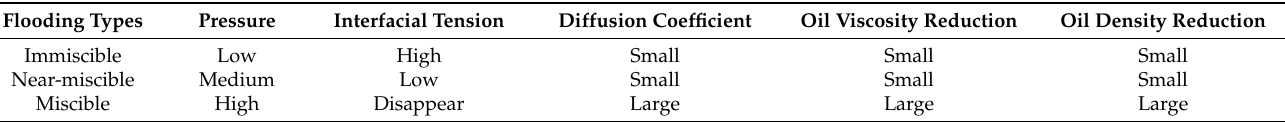
Figure 1. Schematic illustration of pore-scale CO 2 /oil flooding under ( a ) immiscible, ( b ) near-miscible, and ( c ) miscible conditions. Table 1. A comparison between immiscible, near-miscible, and miscible flooding.